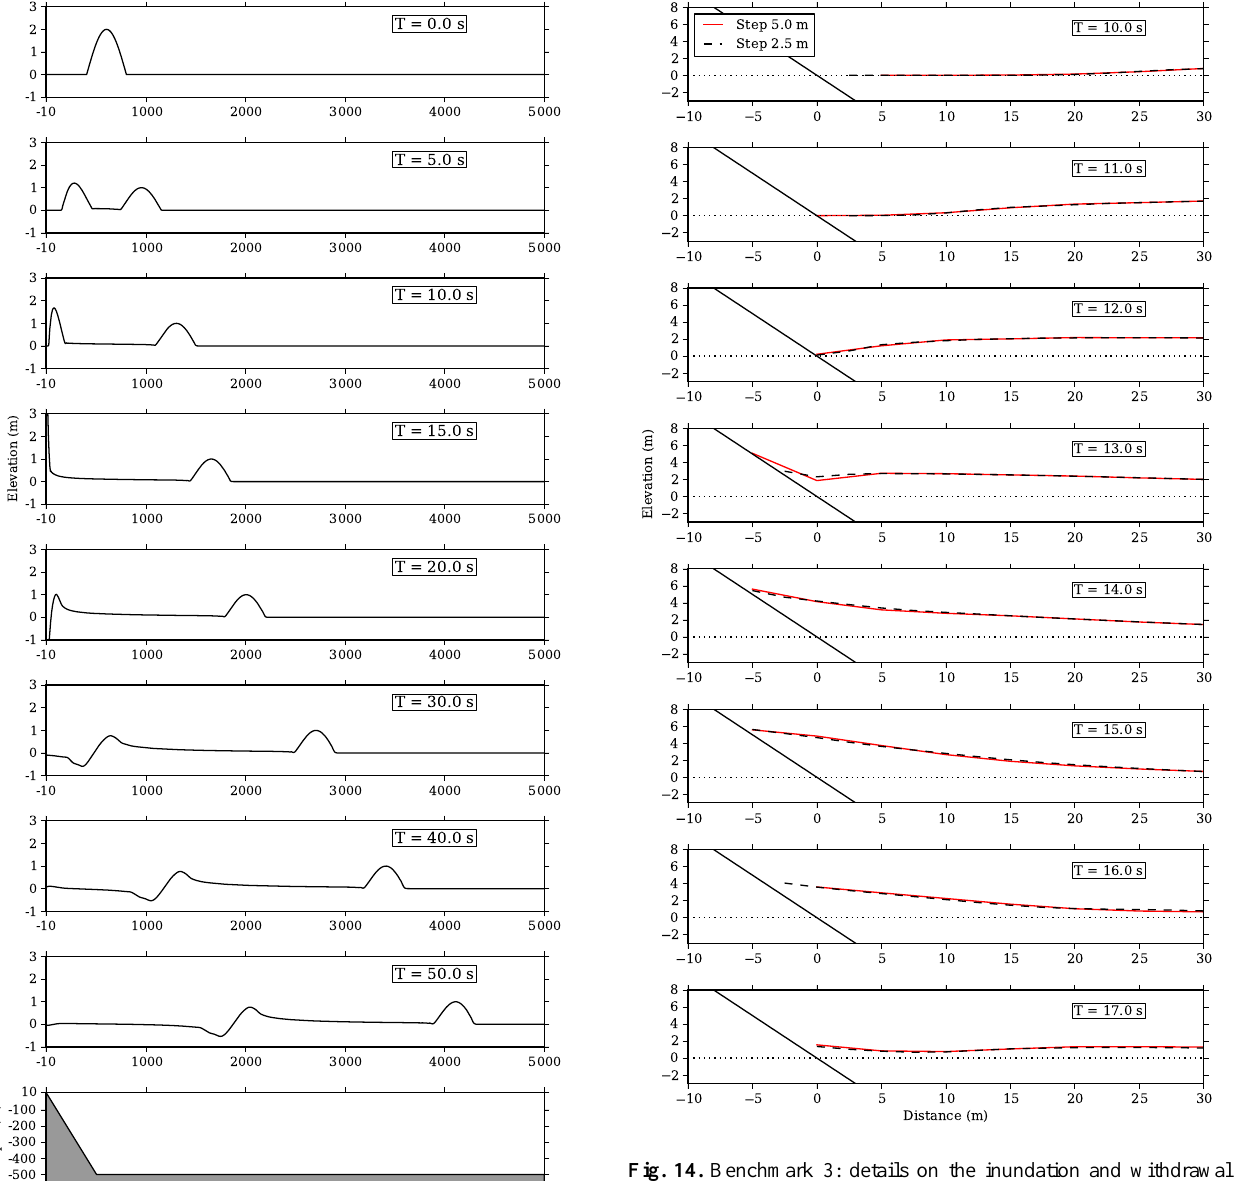
Fig. 14. Benchmark 3: details on the inundation and withdrawal phase. The finer grid step provides a slightly better description of the coastline evolution and it also leads to a better performance of the model in conserving the mass (see Fig. 15). metric sources of data as explained in the paper by Tonini et al. (2011b) and summarised in Table 6 of the same paper. Notice that in that paper the grids used for the tsunami simu- lations differ from the one used in the present application. A zoom on the area of the town of Catania and of its commer- cial harbour is displayed in the right panel of Fig. 20, where one can also see the position of a series of virtual tide gauges placed all in shallow waters (sea depth < 100 m) that enable us to follow the tsunami signal evolution along its way to the shore and into the